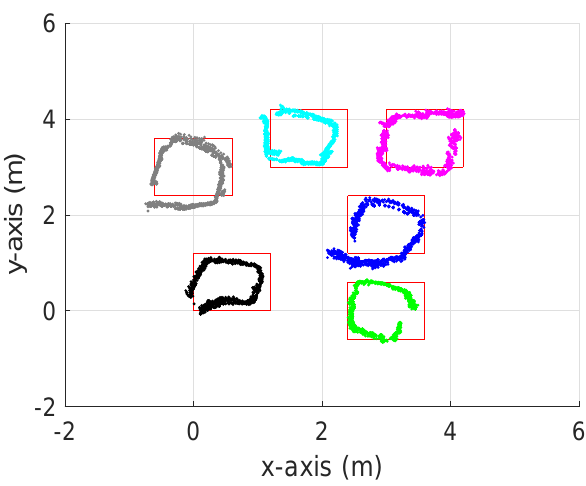
Figure 9. Node tracking performance of the eCDRO-SLAM for Experiment 1.